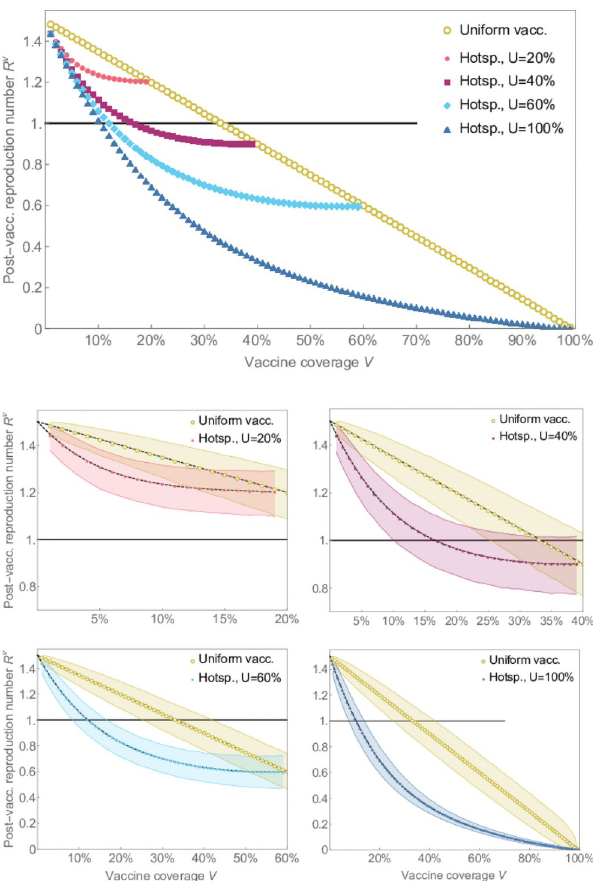
Fig 2. The post-vaccination reproduction numbers for the hot-spotting strategy. The post-vaccination reproduction numbers for the hot-spotting strategy for R 0 = 1.5 with various app usage rates are compared with the uniform vaccination in relation to vaccine coverage. The dots represent the mean reproduction number obtained from 10,000 simulations for each dot. The shaded regions show the intervals that capture 90% of all simulation results. The dashed lines in the bottom figures show the expected post-vaccination reproduction numbers obtained